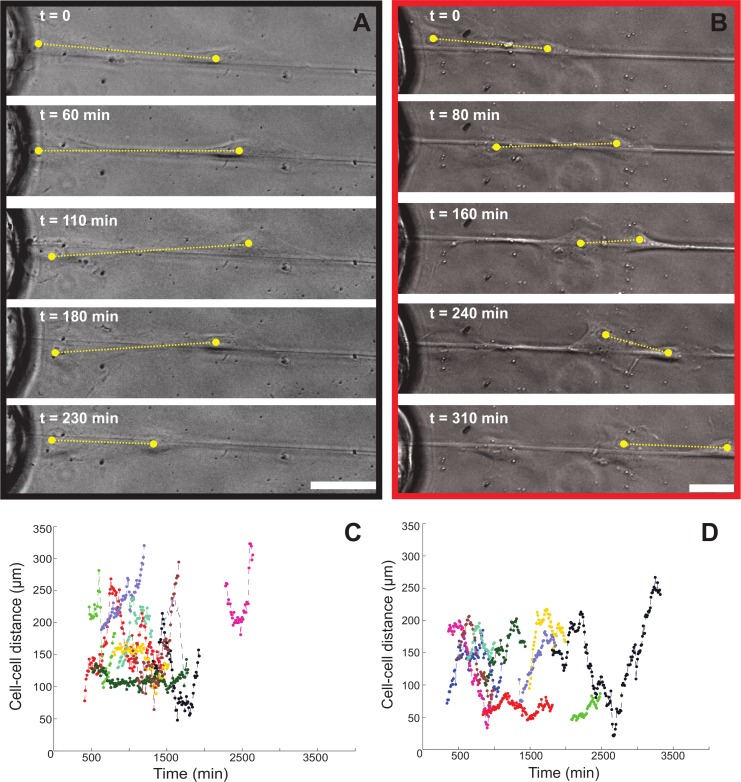
Cell-cell distance does not remain constant during LEC outgrowth.Samples were prepared as described for Fig 4. Cell pairs that moved collectively as a unit were tracked over time and the distance between the cells was measured. (A) A cell pair in the absence of VEGF-A, where the distance between the cells is shortened by the backward movement of the leading cell, whereas the position of the following cell remains mostly constant (S10 Video). (B) A cell pair in the absence of VEGF-A, where the distance between the cells is initially shortened and subsequently lengthened, whereas both cells are moving forward (S11 Video). The distances between 10 cell pairs in the absence (C) or presence (D) of 50 ng/ml soluble VEGF-A in the medium, were plotted over time. Scale bar represents 50 μm.